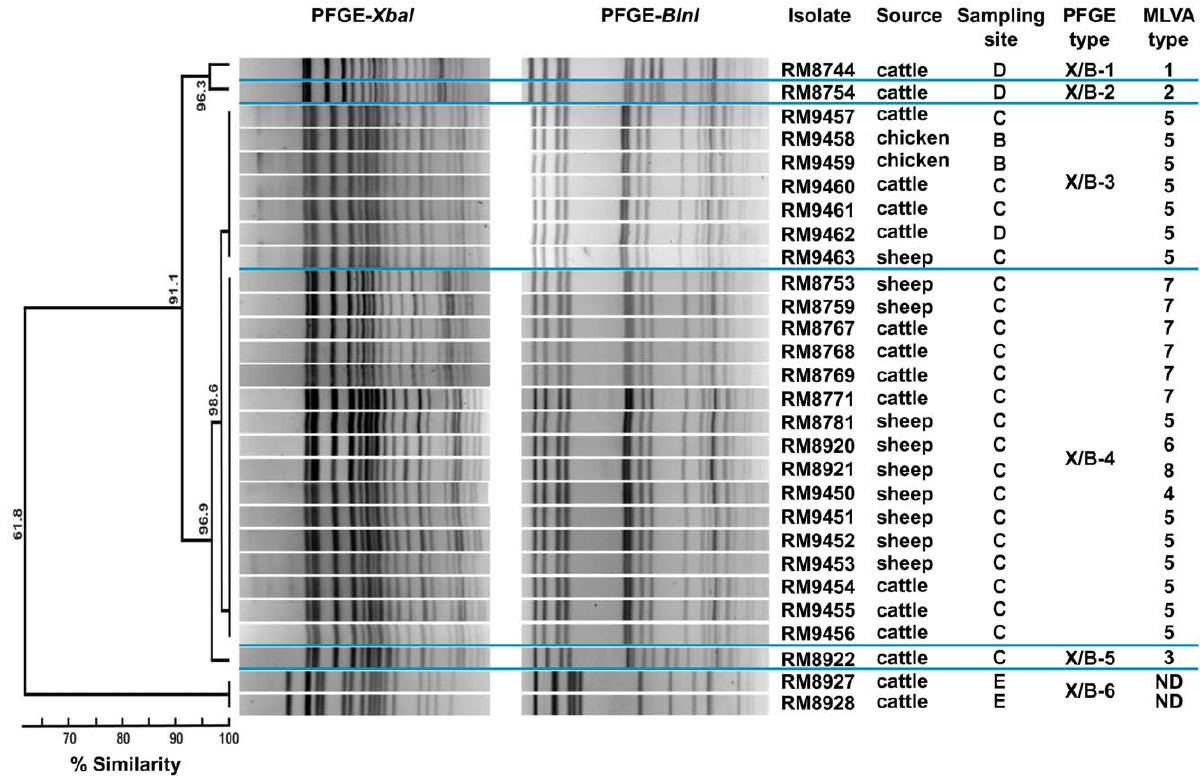
Figure 2. Analysis of the genetic relatedness among the O157 STEC isolates by PFGE and MLVA methods. Dendograms of the combined PFGE types with Xba I and Bnl I restriction enzymes were constructed using Bionumerics software v6.1 with the Dice coefficient and the UPGMA method. MLVA types were designated to each unique profile after analysis of variable tandem repeats in 11 genomic loci using Bionumerics software. ND, Not determined.